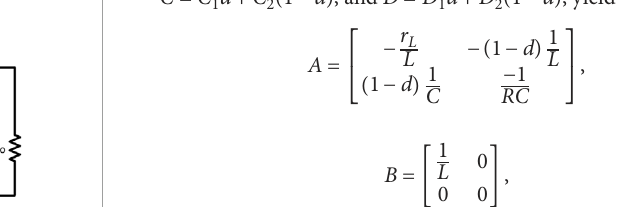
FIGURE 8 Q1 and Q2 are